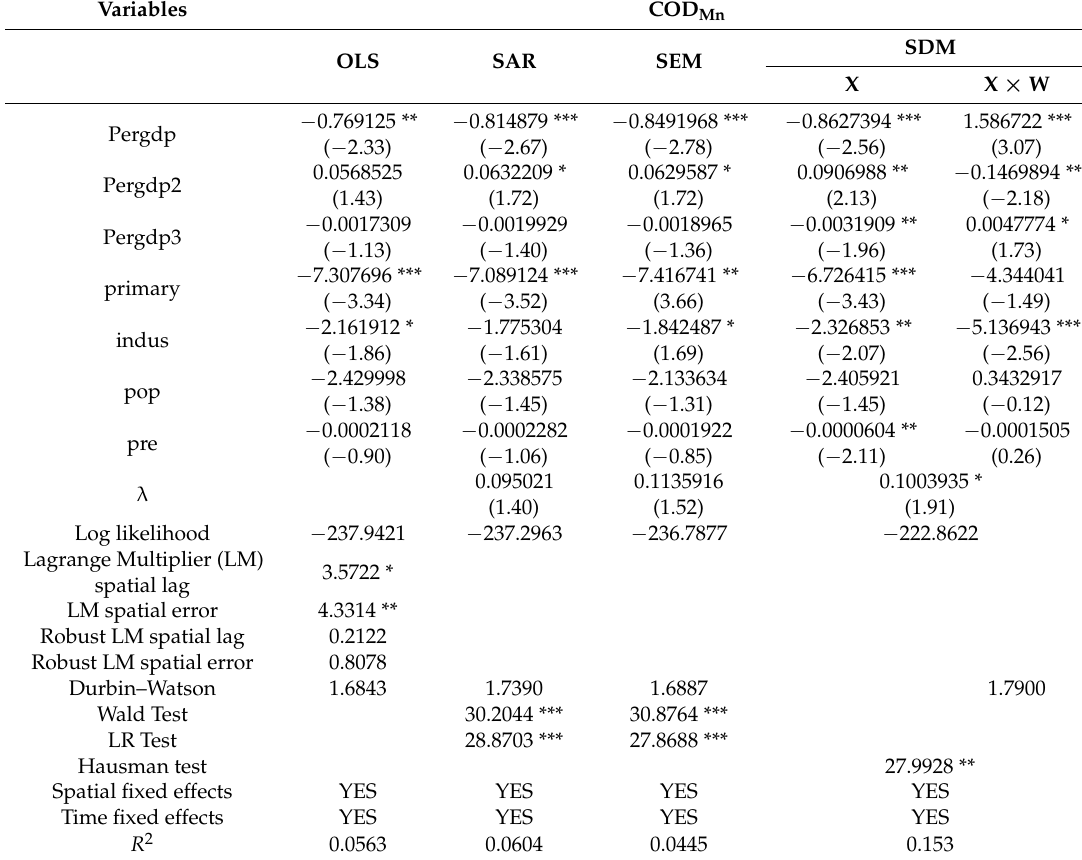
Table 4. Estimation results for COD Mn